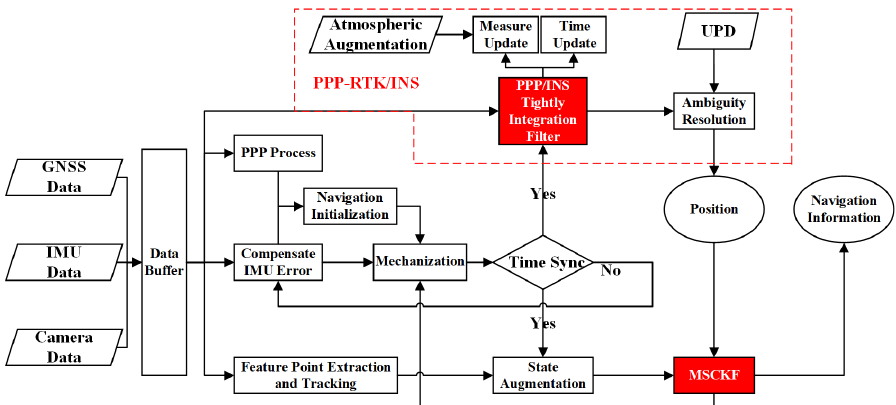
Figure 1. The algorithm structure of PPP-RTK/INS/VISION with a cascading filter.